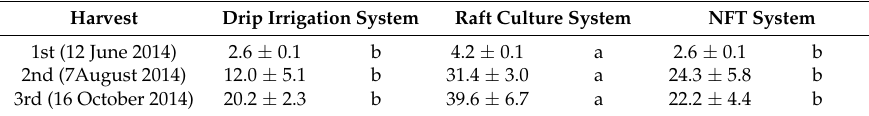
Table 5. Average manganese fruit mineral concentrations ( ± SD) in µ g · g − 1 shown for the three harvests from each of the three hydroponic systems. Different letters indicate significant differences (Tukey’s HSD, n = 3, p < 0.05) between HP